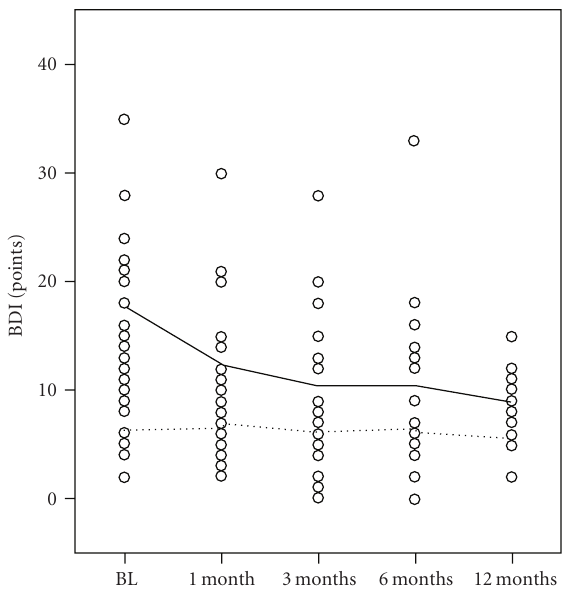
Figure 2: Severity of depressive symptoms. BDI: Becks Depression Inventory. BL: Baseline. Mo: months. Full line: Mean BDI for depressed RLS patients. Spaced line: Mean BDI for RLS patients without depression.